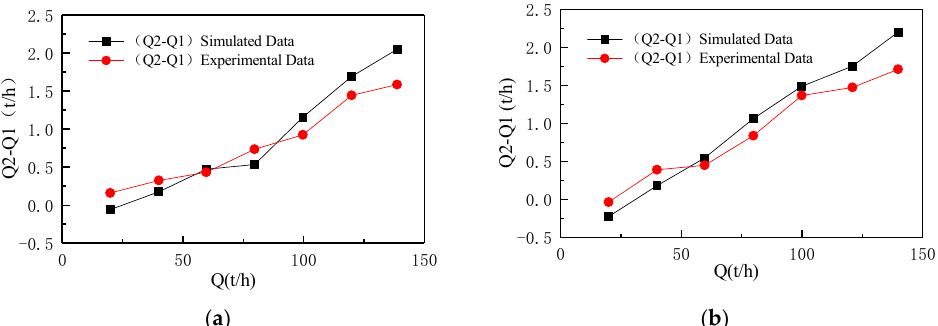
Figure 5. ( a ) Comparison of numerical calculation results and experimental data at 23 °C; ( b ) comparison of numerical calculation results and experimental data at 40 °C .